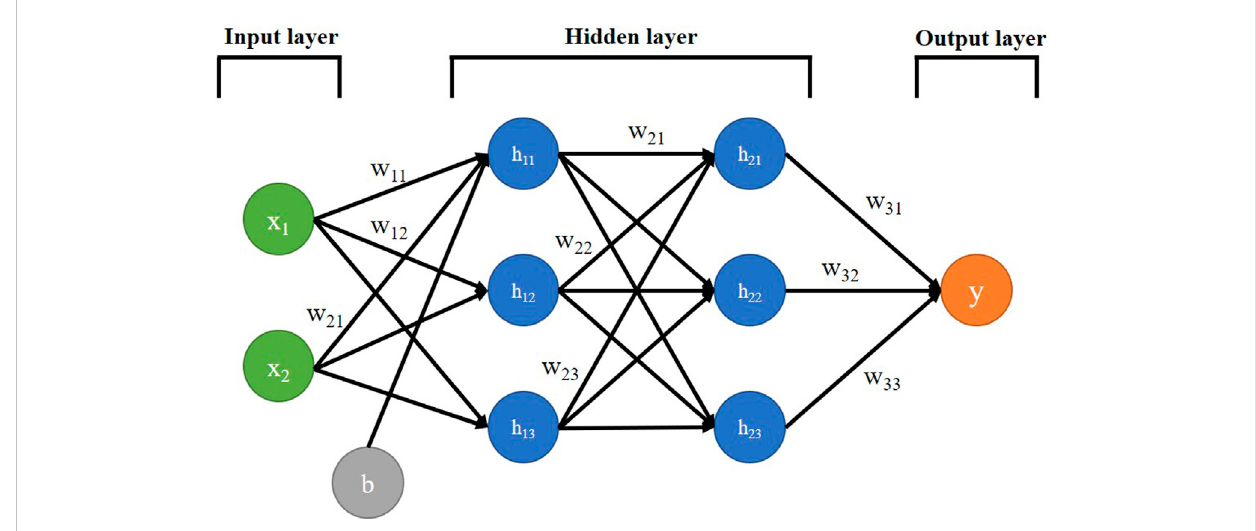
FIGURE 1 Neural network architecture.